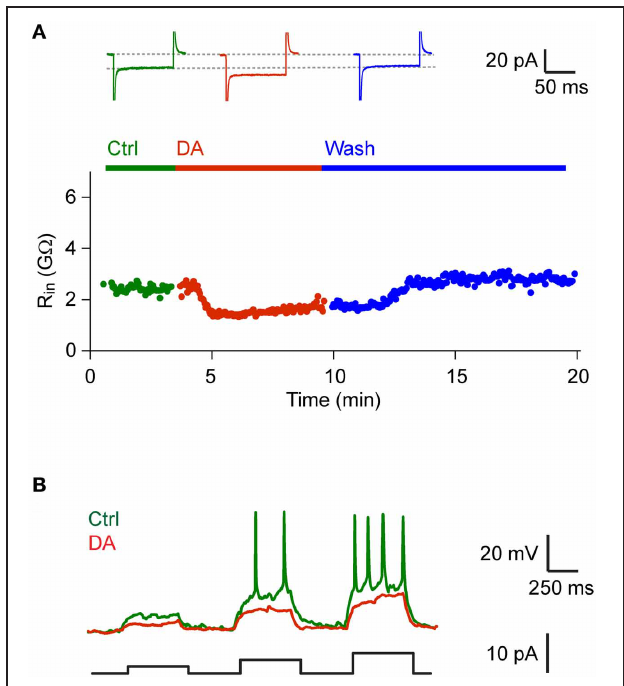
FIGURE 4 | DA decreased input resistance in a subset of Dp neurons. (A) Input resistance as a function of time before, during and after bath-application of DA (50 µ M) in a Dp neuron (vglut2a-GFP-positive). Top: currents measured in voltage clamp in response to voltage steps ( − 30mV) before, during and after exposure to DA. Similar effects of DA on input resistance were observed in a minority of Dp neurons (6/44 neurons; all vglut2a-GFP-positive). (B) Responses to current steps of increasing amplitude recorded in current clamp before and during exposure to DA in the same